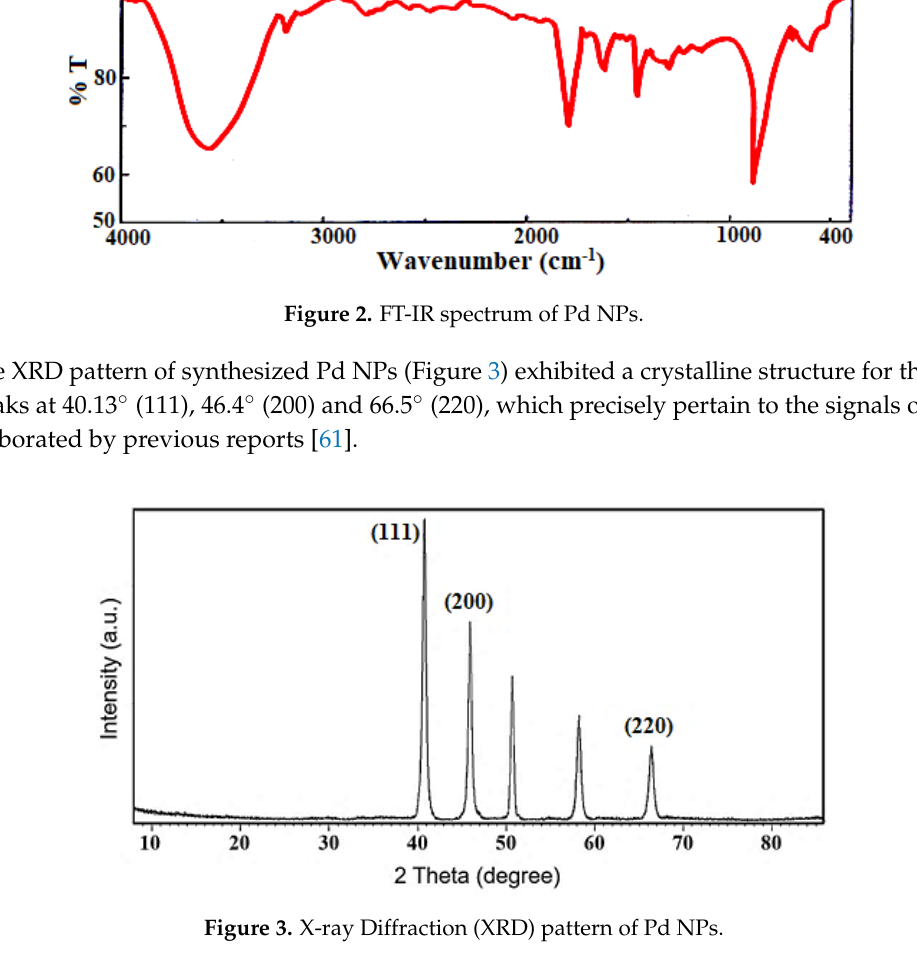
Figure 1. UV-Vis spectrum of plant extract and Pd NPs at different times.